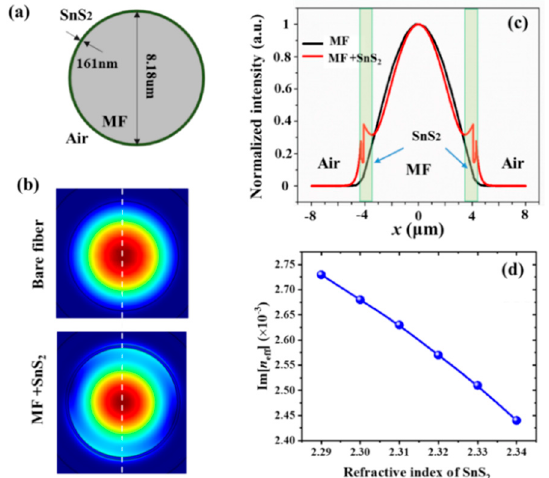
Figure 9. ( a ) The structure of the SnS 2 -coated MF. ( b ) Intensity patterns of fundamental modes with and without SnS 2 film. ( c ) Normalized intensity along the dotted lines in ( b ). ( d ) Imaginary part of effective index of SnS 2 -coated MF changing with refractive index of SnS 2 .